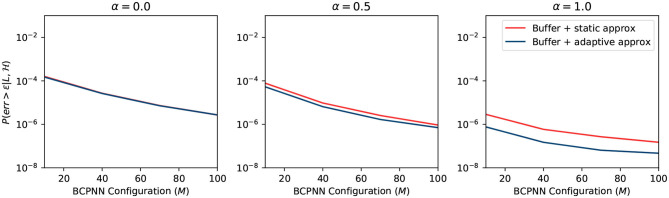
Overall error of different strategy.